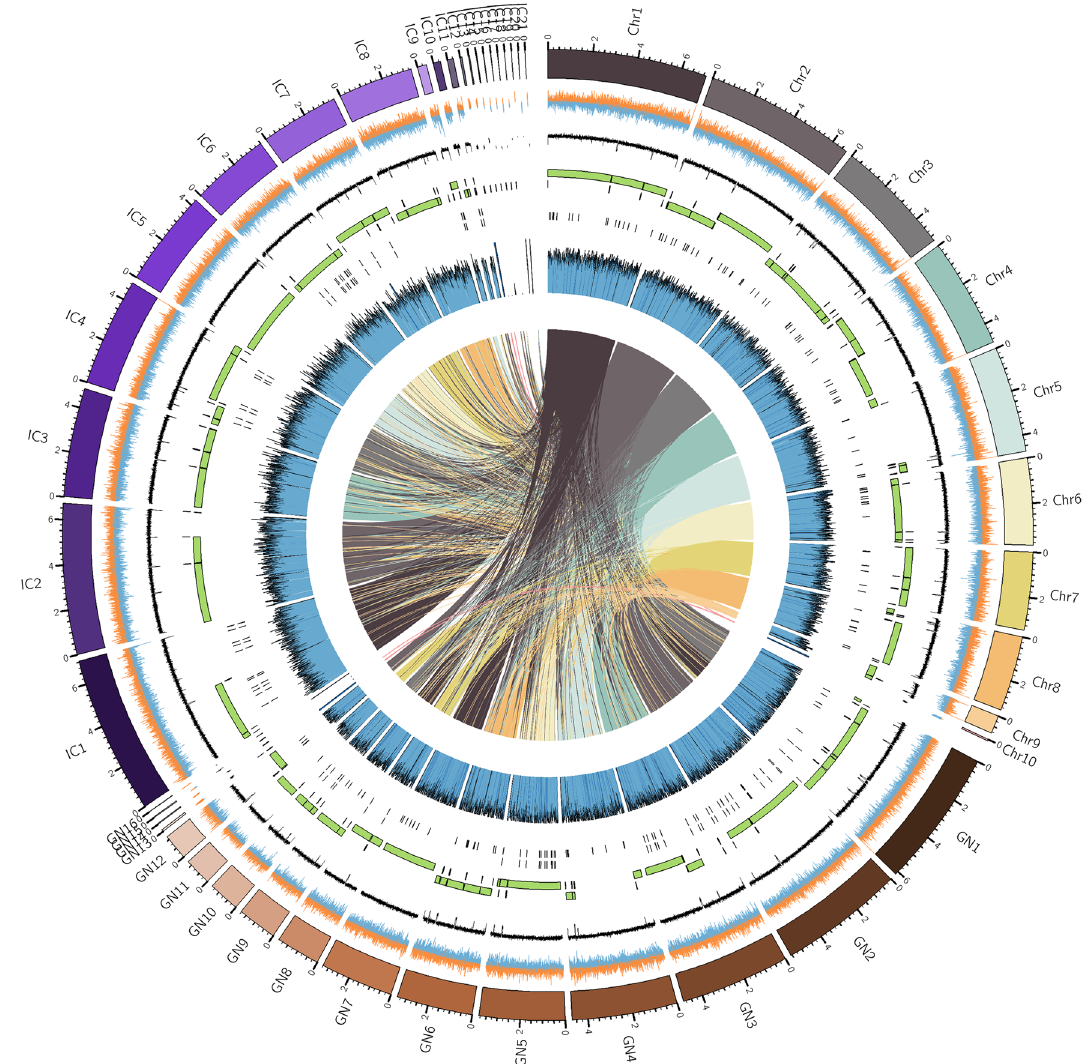
Figure 1. Circos plot showing the the newly assembled genomes of the three Gnomoniopsis castaneae isolates. Concentric circles, from outermost to innermost, show: The MUT401 complete chromosomes and the contigs related to GN01 and ICMP 14040 (indicated as GN and IC, respectively); GC skew, in orange for the forward strand and blue for the reverse strand; GC content percentage; Occultercut R1 region (in green) with an equilibrated GC content and the R0 region (in black) enriched in AT; Predicted effector proteins localized mostly in the R1 region; Illumina short reads coverage on the assembled sequences; Synteny blocks among the isolates generated by Nucmer alignment using MUT401 as reference, indicated as connected coloured